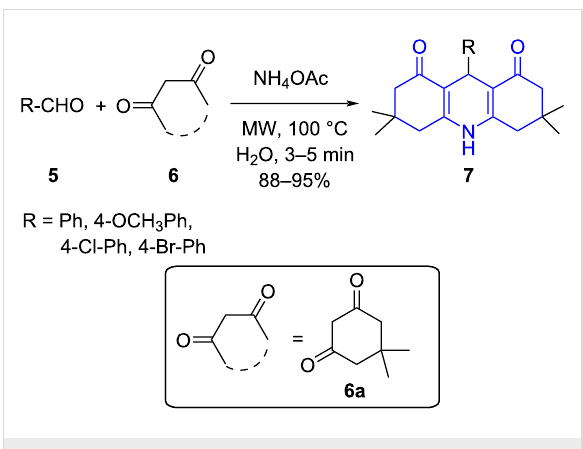
Scheme 1: Synthesis of